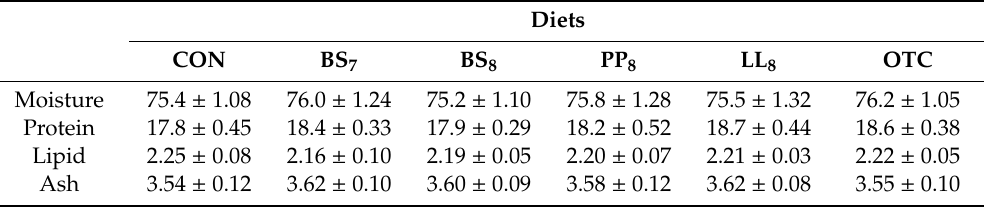
Table 4. Whole-body proximate composition (% dry matter) of juvenile whiteleg shrimp fed the di ff erent probiotics diets for 8 weeks 1 .